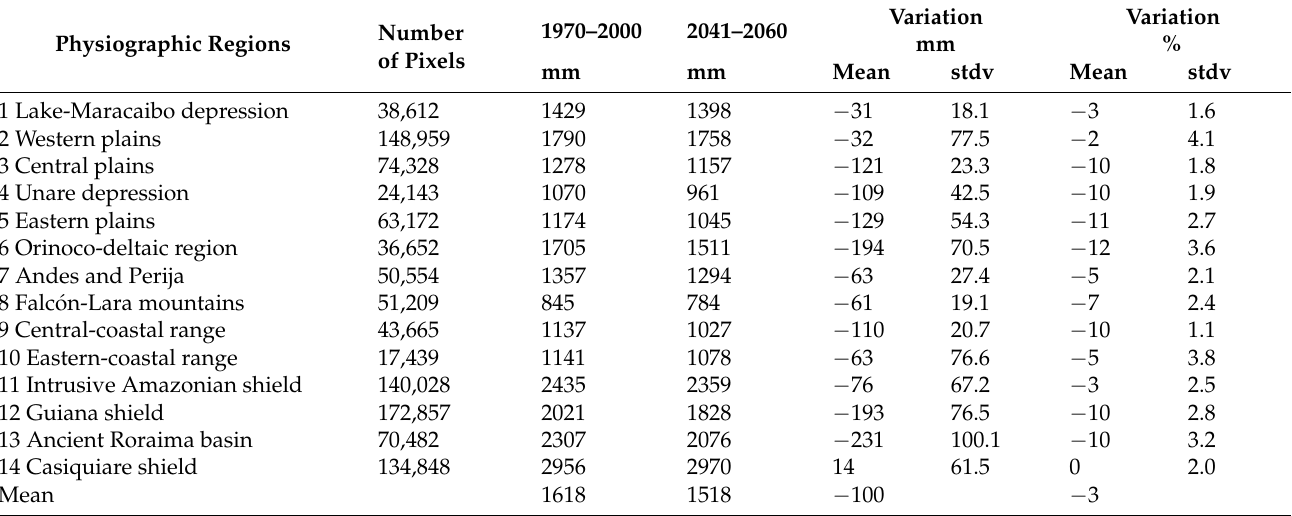
Figure 4. Maps of projected changes in daily minimum temperature between 1970–2000 and 2041– 2060 in Venezuela, with the boundaries of the physiographic regions numbered as in Table 3. Table 3. Projected variation of annual precipitation by physiographic region between 1970–2000 and 2041–2060.